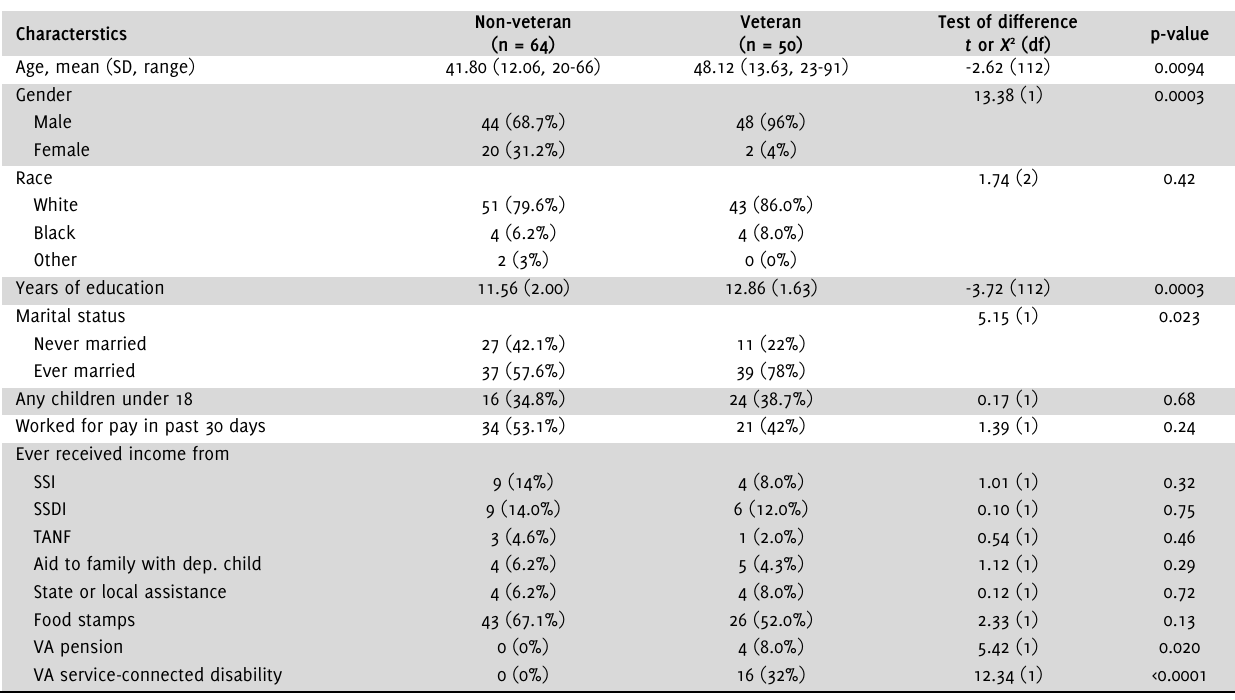
Table 1 . Sociodemographics of Rural Homeless Veterans and